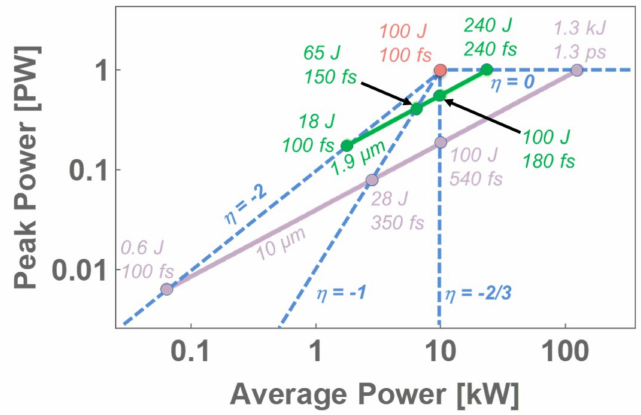
Figure 3. The 100 fs, 100 J is the baseline design point at 0.8 µ m. It should be noted that the number of accelerator stages is kept constant along the η = 0 scaling line, the laser average power per stage is fixed along the η = − 2/3 line, and the laser pulse duration is fixed along the η = − 2 line. Note the considerable variation in laser parameters, all producing the same center-of-mass energy as the 0.8- µ m design